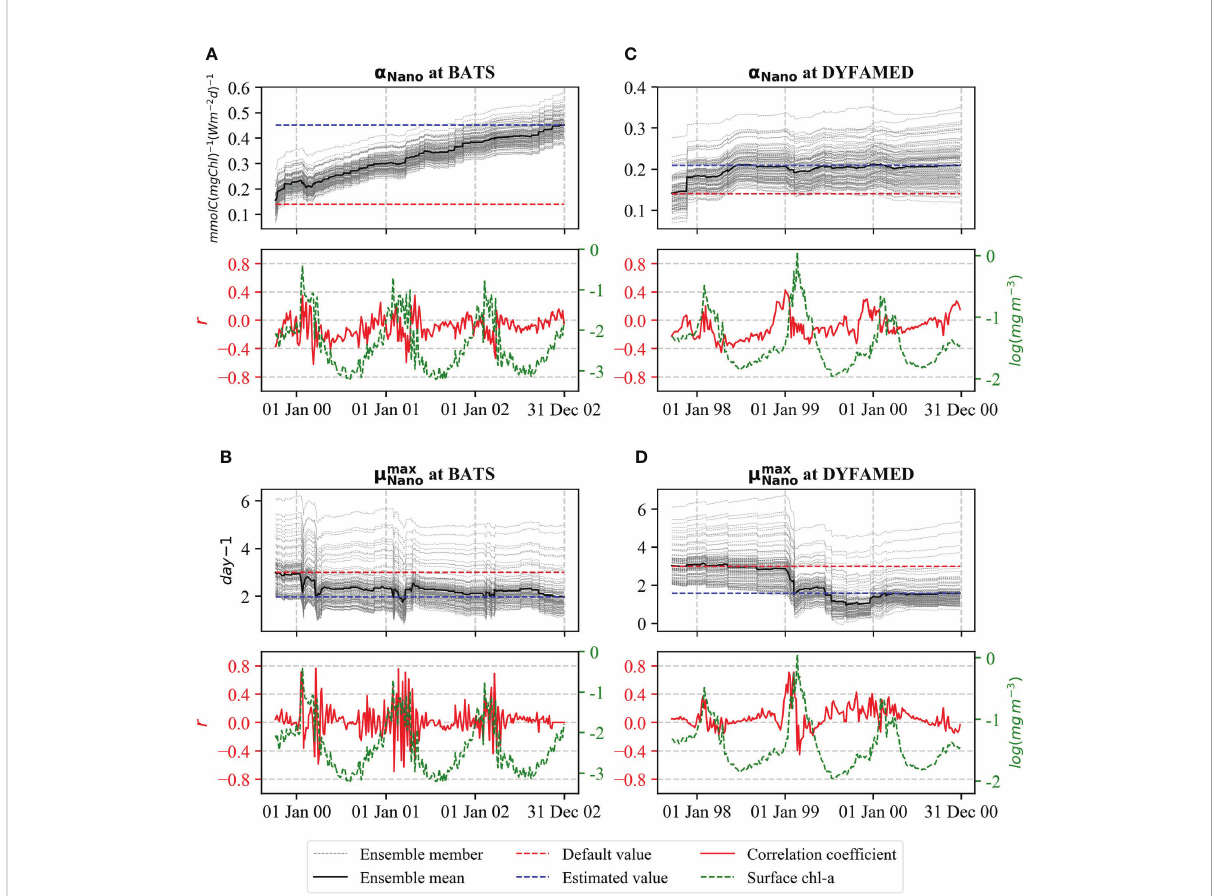
FIGURE 4 Evaluation of a Nano for (A) BATS and (C) DYFAMED and m max Nano for (B) BATS and (D) DYFAMED for combined assimilation of satellite surface chl-a and in situ NPP simulations of EXP Joint_DP . Top panels show the ensemble evaluation (gray dashed line) and the associated ensemble means (black solid line). The default and estimated values are shown as dashed lines (red for default and blue for estimated). The bottom panels show the correlation of parameter value with the observed surface chl-a concentration at each assimilation